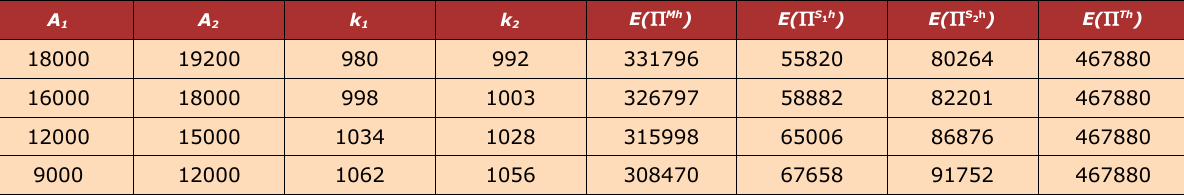
Table 2. Optimal Combination Values about Buy-back Cost and Compensation